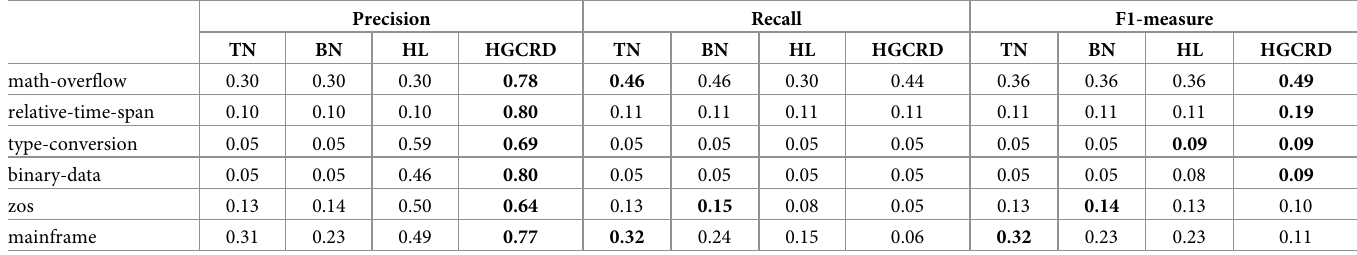
Table 6. Precision, recall and F1-measure for TopNeighbors (TN), BestNeighbors (BN), Hyperlocal (HL) and HG-CRD on mathoverflow-answers hypergraph and five randomly chosen classes from stackoverflow-answers hypergraph dataset (which are relative-time-span, type-conversion, binary-data, zos and mainframe). Precision